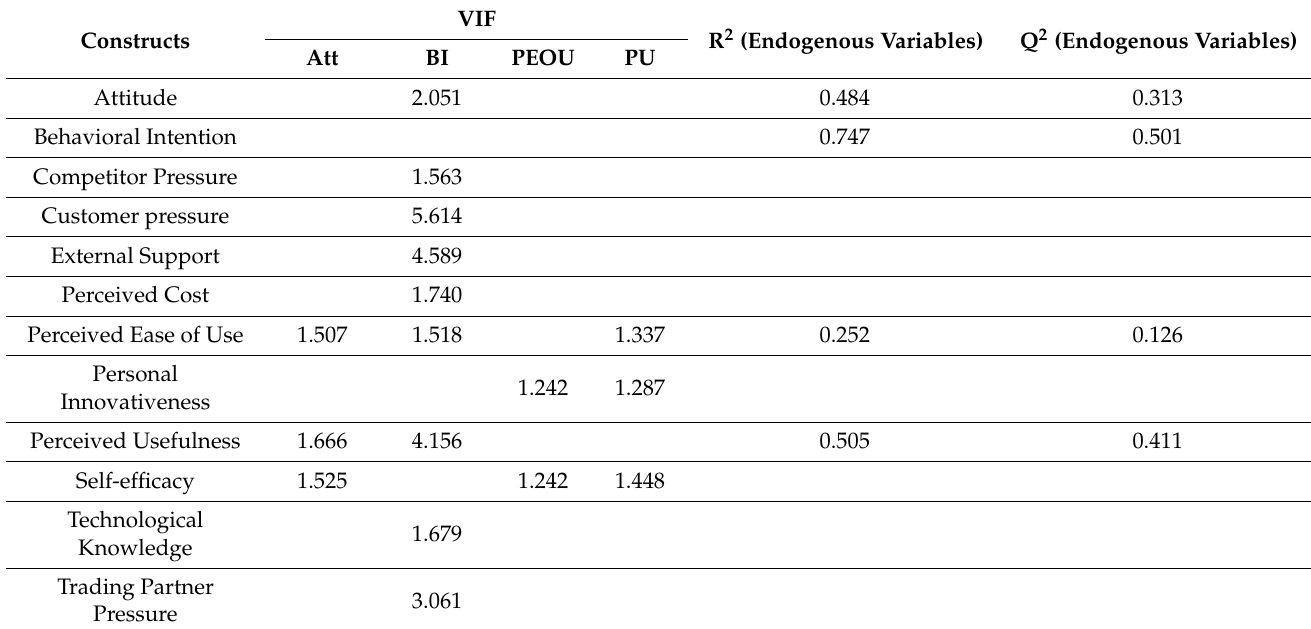
Table 4. VIF value, R 2 , and Q 2